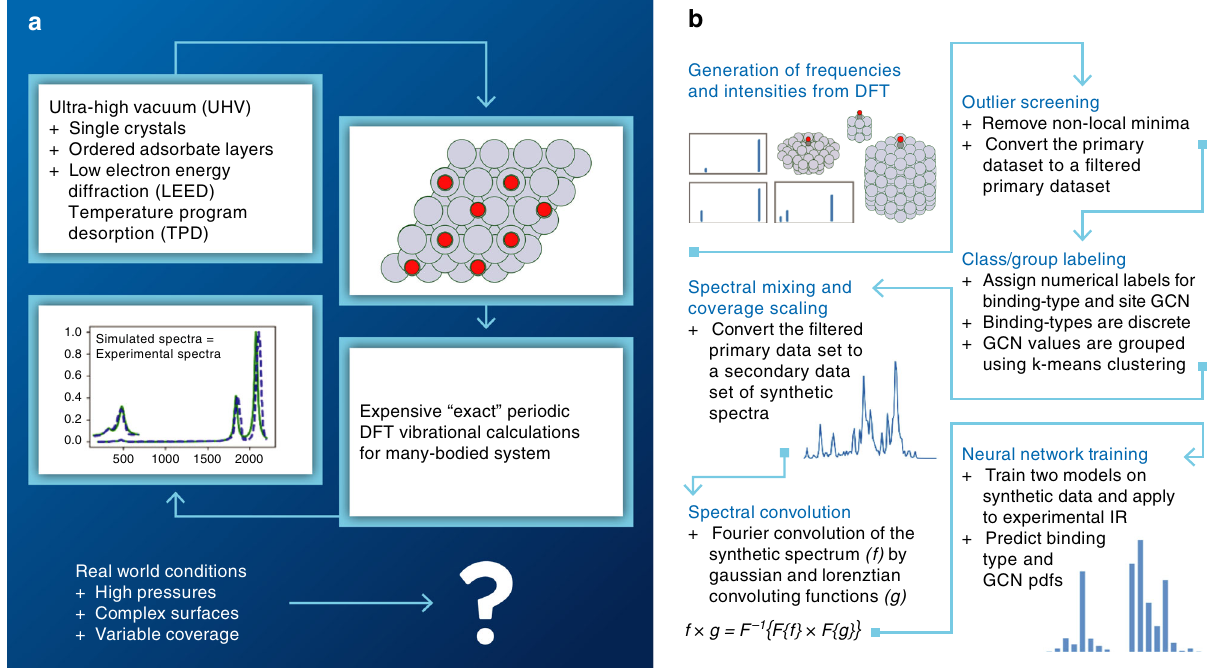
Fig. 1 Approach combining expert knowledge and spectroscopic data to close the materials gap. The materials gap ( a ) and corresponding work fl ow ( b ) to address this gap. a Surface structure with adsorbates can be characterized only in controlled and limited environments. Materials used in industrially relevant catalysis have no reliable characterization method to quantify the structure of the surface in detail. This gap between studies that can be performed with model catalysts and those on complex materials is known as the materials gap. b Develops a work fl ow to address this gap via physics- and data-driven surrogate models. DFT generates spectra of single CO molecules chemisorbed on different sites of many Pt nanoparticles. After non-local minima (outliers) are removed, a data-driven approach is used to assign labels to each data point that describe structure. The binding-type (atop, bridge, threefold, and fourfold) is naturally discrete and given a numerical class value 1 – 4. The coordination environment of the site is quanti fi ed by its GCN value, which is nearly continuous. K-means clustering is an unsupervised learning method that assigns GCN values to discrete GCN groups necessary for data- driven structure quanti fi cation. A physics-driven surrogate model is then applied to expand the fi ltered primary DFT-based dataset to a secondary dataset of complex spectra. This surrogate model includes coverage scaling factors that quantitatively link shifts in frequencies and intensities of the primary fi ltered data set to spatial coverage. The coverage scaling is done simultaneously with spectral mixing where individual simple-CO spectra are summed to enforce physics-driven coverage constraints. The last step in the physics-driven surrogate model is spectral convolution accomplished by a Fourier transform to generate synthetic complex spectra with varying line widths. Hundreds of thousands of complex spectra associated with various distributions of occupied sites, with varying coverage and differing line widths, are generated. In generating complex spectra, the binding-type and GCN group of the individual spectra are tallied and used to generate binding-type and GCN probability distribution functions (pdfs) that correspond to each complex spectrum. A data-driven surrogate model is trained on these synthetic complex spectra to learn microstructure. After training on synthetic complex spectra, the model is applied to experimental